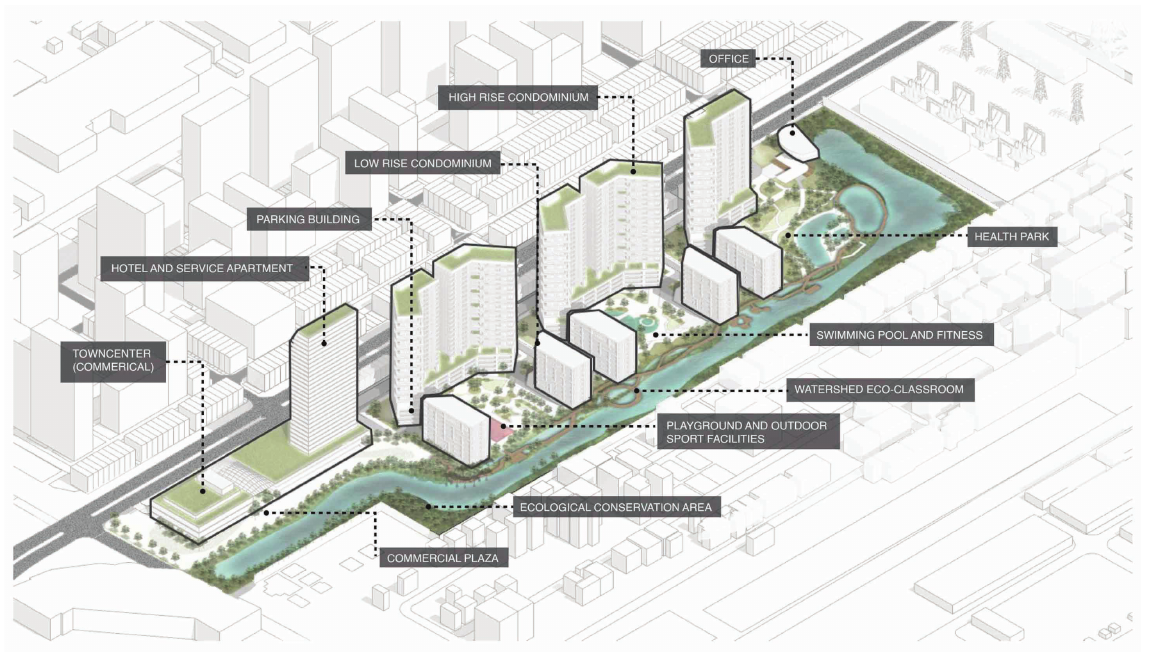
Figure 12. Integrated residential, commercial, and educational opportunities, with diverse green space/public space in the Digital Village Fora Estuary concept. Graphics credits to Kanokwan Srisamer, Manus Janthik, Panyawat Terdkeat, Wipawee Khantikittikul, UD327 class.